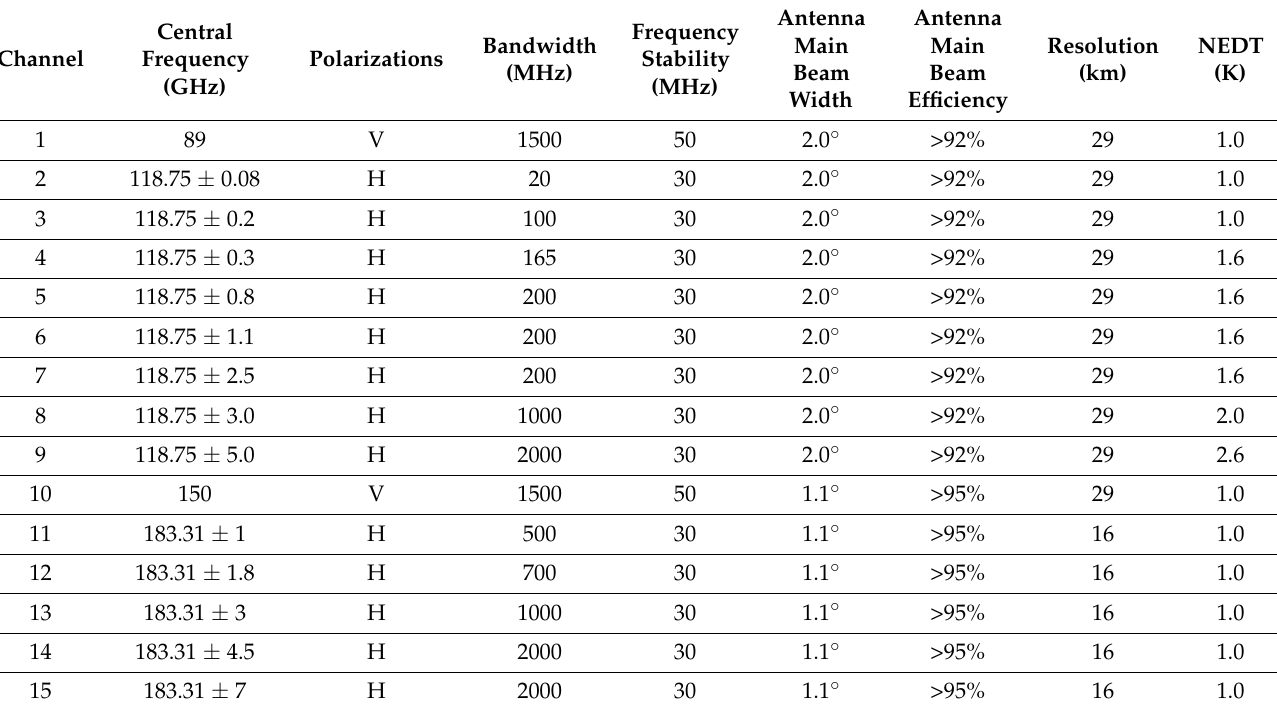
Table 1. Features of the channels for